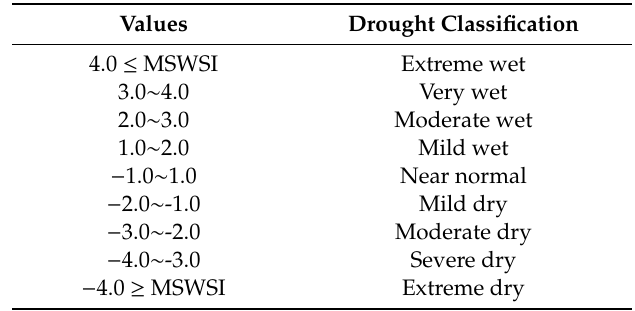
Table 2. Classification range for the Modified Surface Water Supply Index (MSWSI)